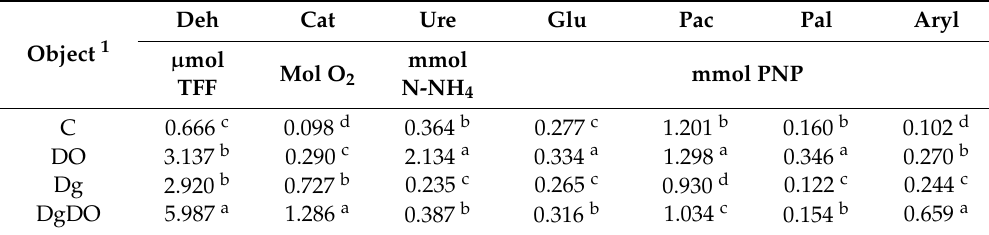
Table 1. Effect of diesel oil (DO) and Dactylis glomerata (Dg) on soil enzyme activity, kg d.m. soil h − 1 .